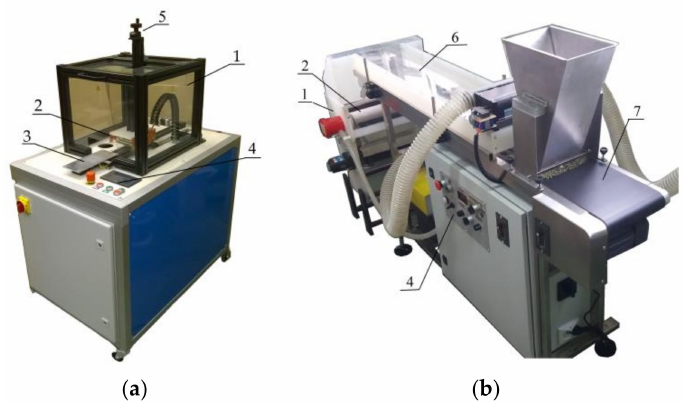
Figure 11. View of devices for decontamination of loose organic materials using DBD discharges developed and tested by the authors: ( a ) device with a sliding electrode; ( b ) device with rotating electrodes; 1—discharge chamber, 2—electrodes assembly, 3—transport trolley, 4—operator